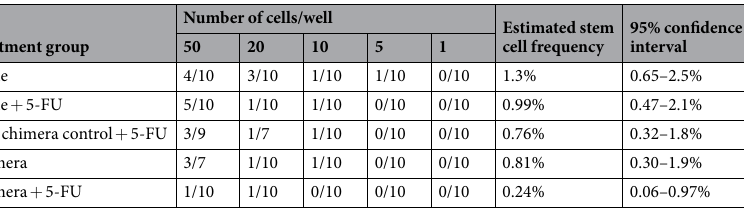
Table 1. Elimination of cancer stem cells via combined in vivo survivin knockdown and 5-FU treatment in vivo